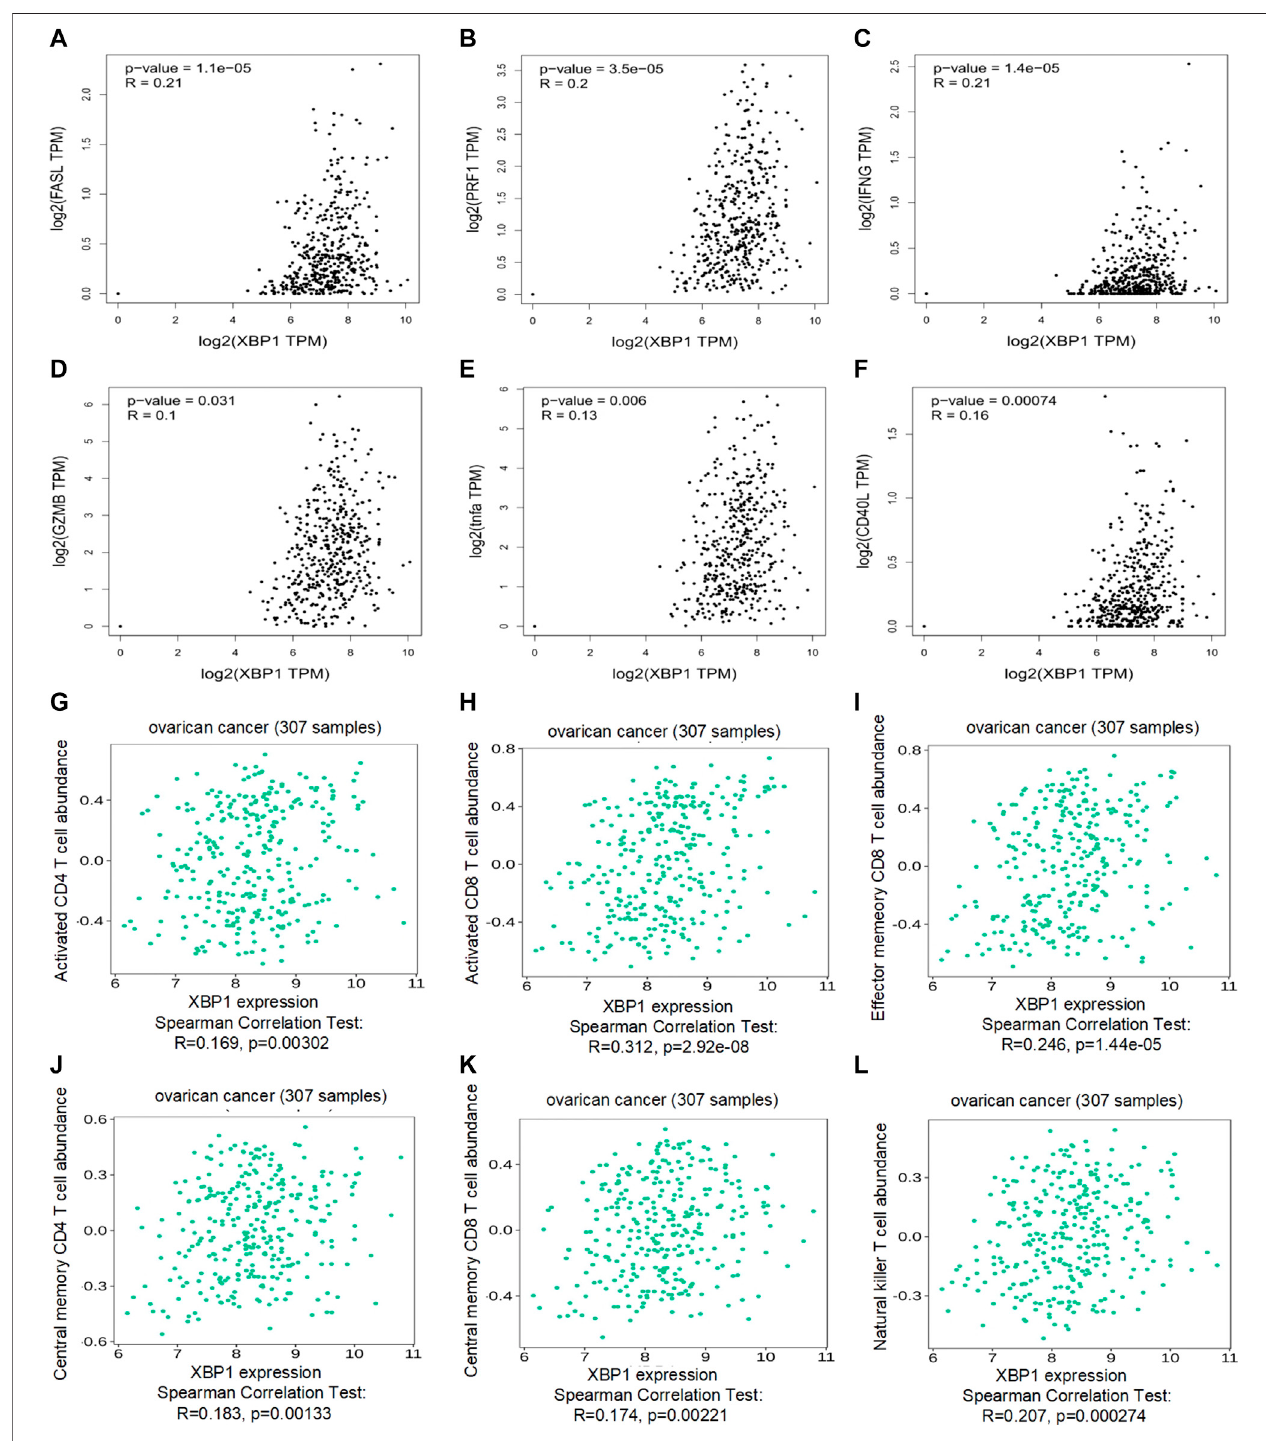
FIGURE4| ImmunecorrelationofXBP1inovariancancer. (A) CorrelationanalysisofXBP1andFASLinovariancancer. (B) CorrelationanalysisofXBP1andRPF1 in ovarian cancer. (C) Correlation analysisof XBP1 and IFNG in ovarian cancer. (D) Correlation analysis ofXBP1 and GZMB in ovarian cancer. (H) Correlation analysisof XBP1 and TNFa in ovarian cancer. (E) Correlation analysis of XBP1 and CD40L in ovarian cancer. (F) Correlation analysis of XBP1 and actived CD4 T cell Abundance in ovarian cancer. (G) Correlation analysis of XBP1 and actived CD4 T cell Abundance in ovarian cancer. (H) Correlation analysis of XBP1 and actived CD8 T cell Abundance in ovarian cancer. (I) Correlation analysis of XBP1 and effector memeory CD4 T-cell Abundance in ovarian cancer. (J) Correlation analysis of XBP1 and central memory CD4 T-cell Abundance in ovarian cancer. (K) Correlation analysis of XBP1 and central memory CD8 T-cell Abundance in ovarian cancer. (L) Correlation analysis of XBP1 and Nature killer T-cell Abundance in ovarian cancer. The pair-wise gene expression correlations of two genes were made by GEPIA, or between one geneandseveralsignaturesinovariancancer(TCGAtumor)usingSpearmanmethod.Thedetailed p -valueandRwereindividuallypresentedasindicatedineachpanel. The statically signi fi cant difference was considered when a p -value is < 0.05.